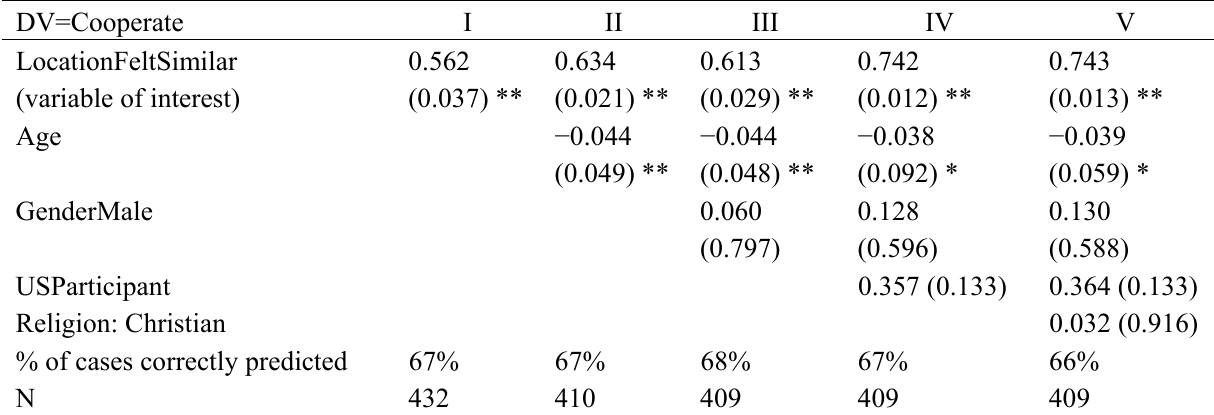
Table 4. Logit Regression Results for